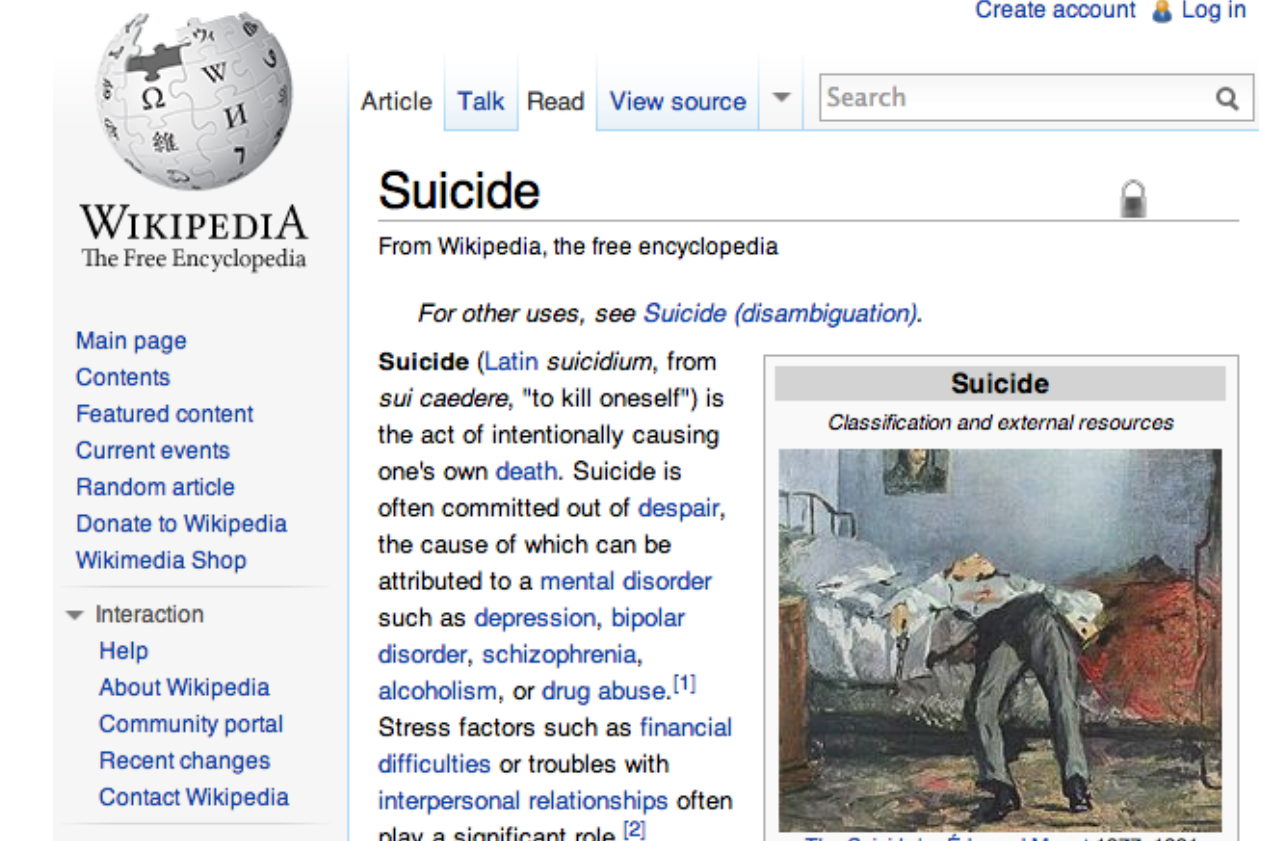
Figure 1. Suicide page on